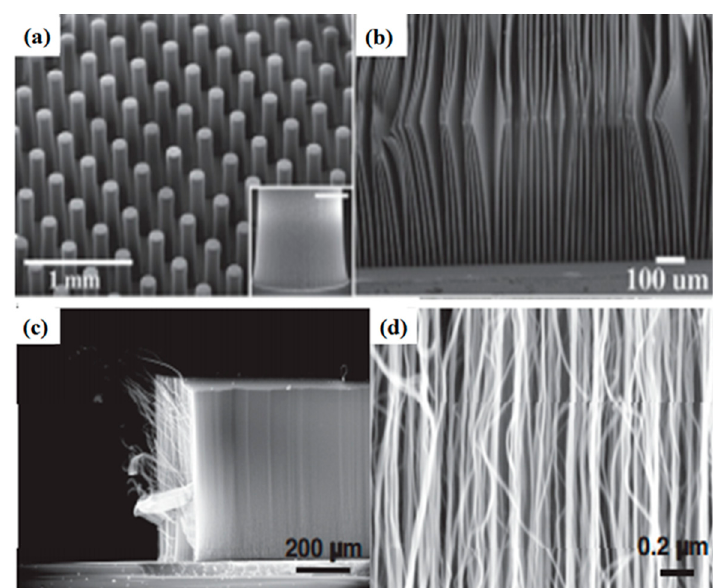
Figure 7. ( a ) SEM micrograph of cylindrical pillars of SWCNTs; ( b ) SEM images of 10 μ m thick SWCNT sheets. Reproduced with permission from [73]. Copyright AAAS, 2004. ( c , d ) super ‐ aligned MWNT array with different magnifications. Reproduced with permission from [84]. Copyright Elsevier, 2009.